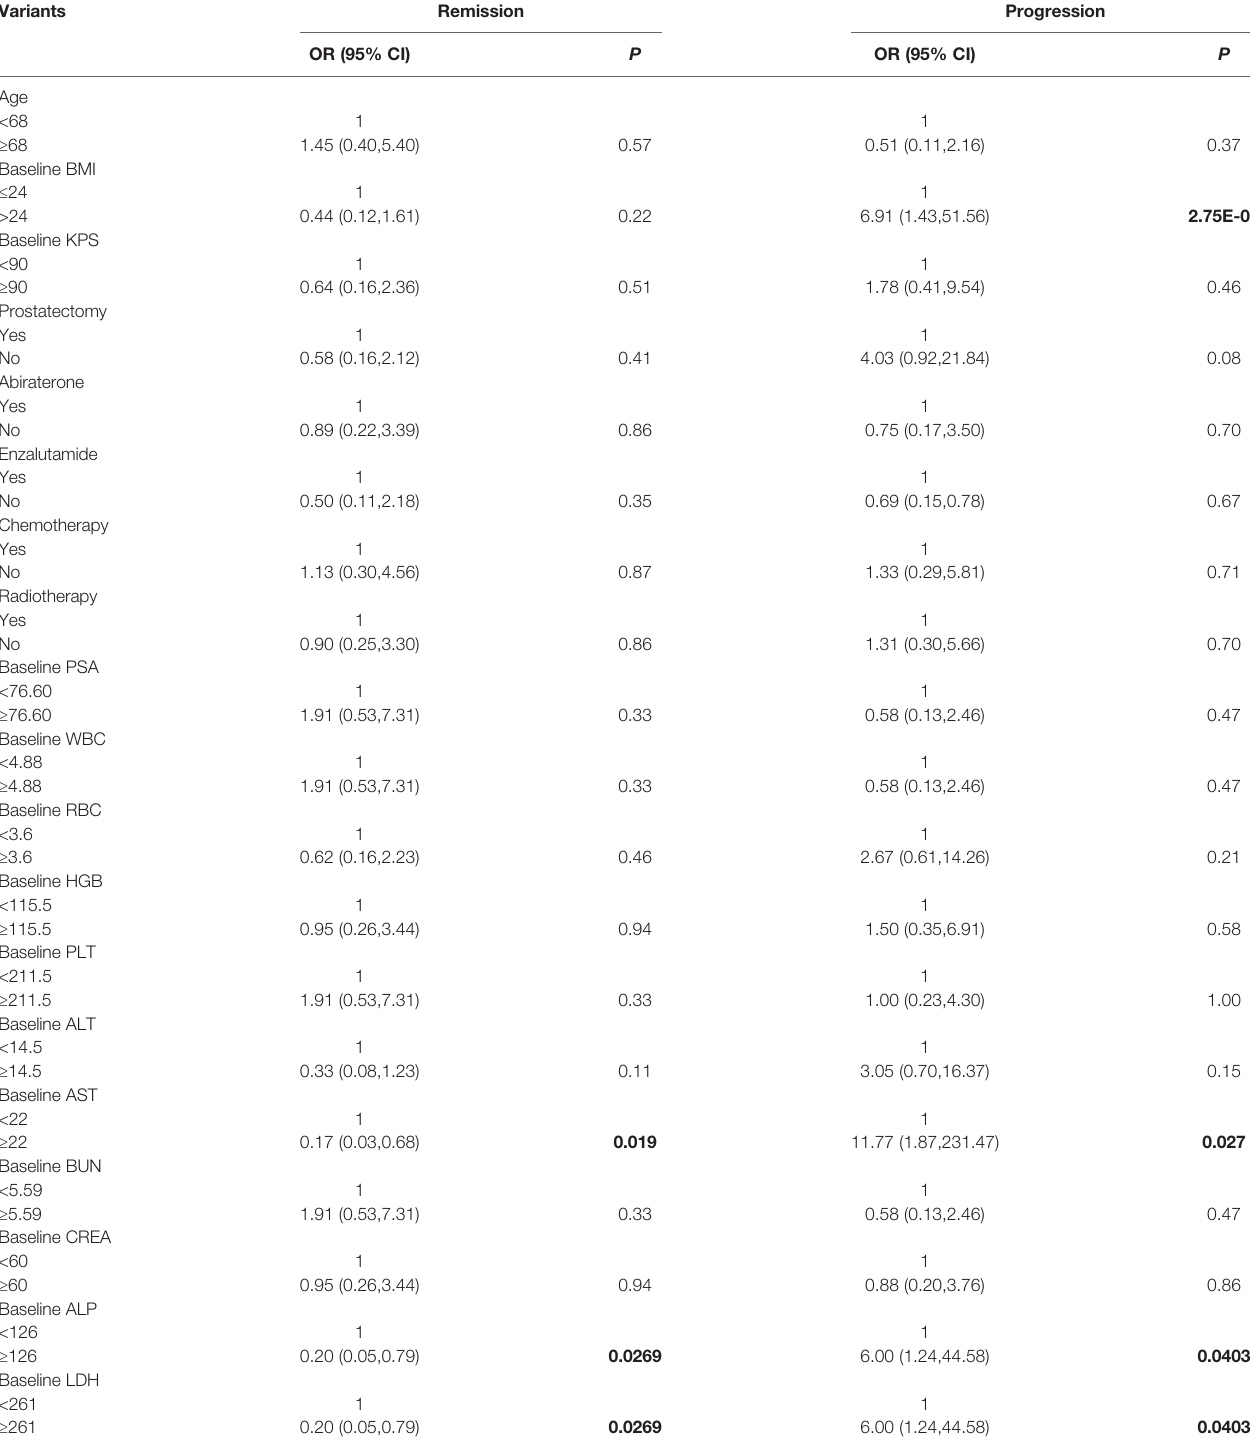
TABLE 4 | Univariate logistic regression analysis on basic factors associated with therapeutic